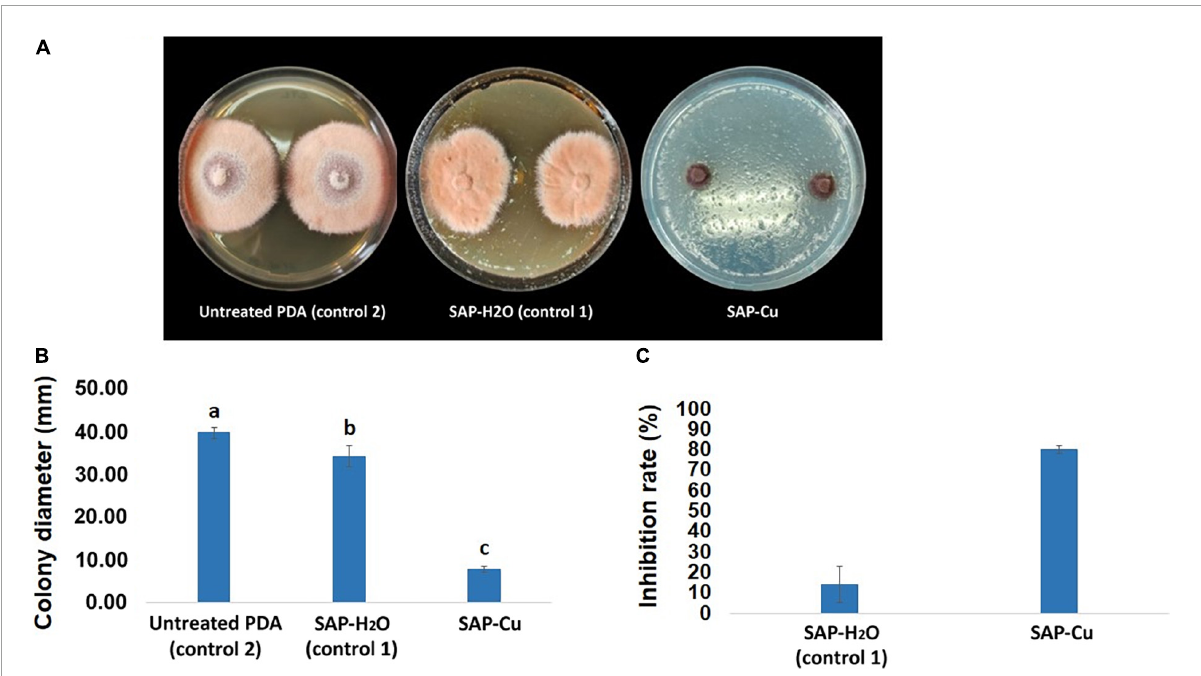
FIGURE7 Inhibition effects of super absorbent polymer (SAP) containing copper at the concentration of 0 (SAP-H 2 O–control 1) and 236 mM super absorbent polymer containing copper (SAP-Cu) over untreated potato dextrose agar (PDA) (control 2) on the mycelial growth of Plenodomus tracheiphilus isolate Pt 42 after 10 days of incubation at 25 ◦ C on PDA. (A) Comparison of cultures from different treatments, (B) mean colony diameter (mm), and (C) mean inhibition rate (%). In B, columns with different letters are significantly different according with the Tukey’s HSD (Honestly Significant Difference) p = 0.05. Bars represents SD.